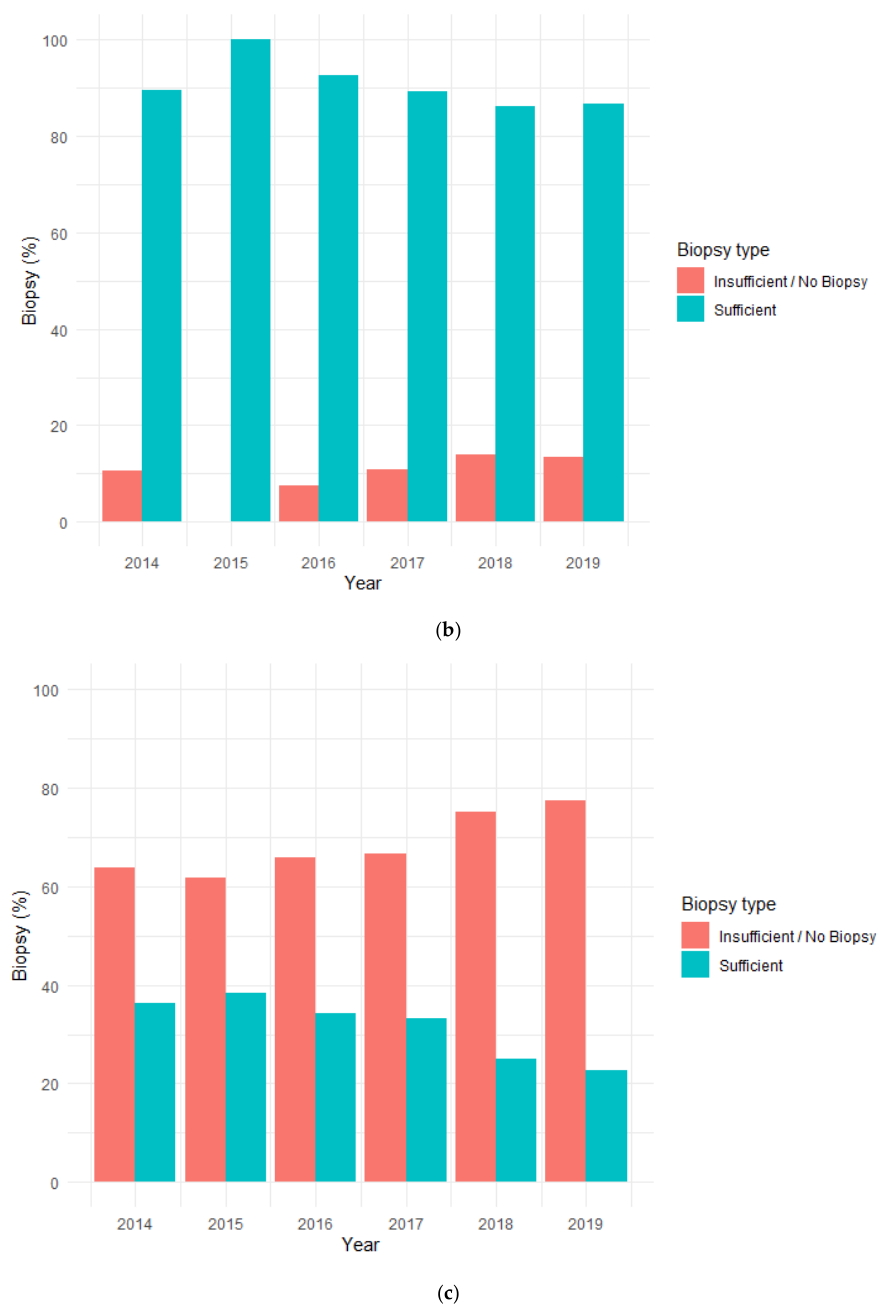
Figure 2. ( a – c ) . Bar chart illustrating the proportional distribution of biopsies for ( a ) all lesions